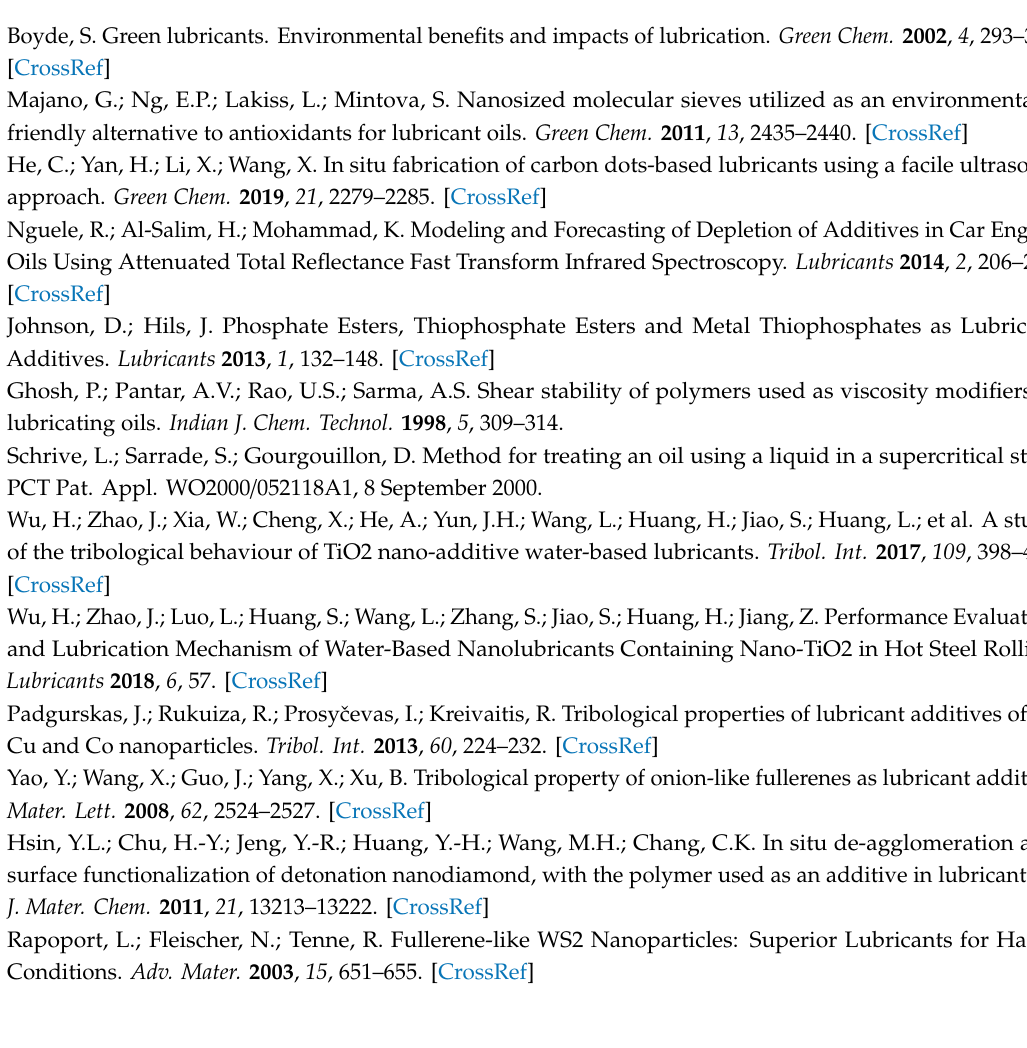
Supplementary Materials: Available online at http: // www.mdpi.com / 1996-1944 / 12 / 17 / 2830 / s1, Figure S1: XRD patterns of fresh LTL nanosized zeolite (red) and LTL nanosized zeolite separated from lubricant oxidized at 150 ◦ C for 24 h (black), Figure S2: Particle size distribution of LTL nanosized zeolite crystals determined by dynamic light scattering (DLS), Figure S3: N 2 adsorption (full circles) and desorption (empty circles) isotherm of LTL nanosized zeolite crystals, Figure S4: (up) 1 H NMR spectra of the fresh lubricants; (down) zoom on the aromatic region of the spectra, Figure S5: FTIR spectra of the fresh lubricants, Figure S6: Evolution of the FTIR band area of P–O–C bonds for lubricants oxidized at 150 ◦ C for 16 h and 24 h in the presence (LTL) or absence (NZ) of LTL nanosized zeolite. Inset : FTIR spectra of SA-C3 before oxidation (black) and after 24 h of oxidation in the presence (blue) and absence (red) of LTL nanosized zeolite, Figure S7: 1 H NMR spectra of SA-C2, before (blue) and after 24 h of oxidation at 150 ◦ C in the absence (green) or presence (violet) of LTL nanosized zeolite, Figure S8: Deconvolution of C = O FTIR band vibrations of the lubricant samples (a) SA-C2 Fresh, (b) SA-C2, no zeolite, 150 ◦ C, 24 h, (c) SA-C2, LTL, 150 ◦ C, 24 h, (d) SA-C3 Fresh, (e) SA-C3, no zeolite, 150 ◦ C, 24 h, (f) SA-C3, LTL, 150 ◦ C, 24 h, (g) SB-C2 Fresh, (h) SB-C2, no zeolite, 150 ◦ C, 24 h, (i) SB-C2, LTL, 150 ◦ C, 24 h, (j) SB-C3 Fresh, (k) SB-C3, no zeolite, 150 ◦ C, 24 h, and (l) SB-C3, LTL, 150 ◦ C, 24 h, Figure S9: Evolution of the FTIR band area of C = O bonds at 1705 cm − 1 for lubricants oxidized at 150 ◦ C for 24 h in the presence (blue) and absence (red) of LTL nanosized zeolite, Figure S10: FTIR spectra of (a) fresh LTL and LTL zeolite extracted after 24 h of treatment at 150 ◦ C from (b) SA-C3, and (c) SA-C2 lubricant samples, Table S1: Viscosity of lubricants used in the study measured at 25 ◦